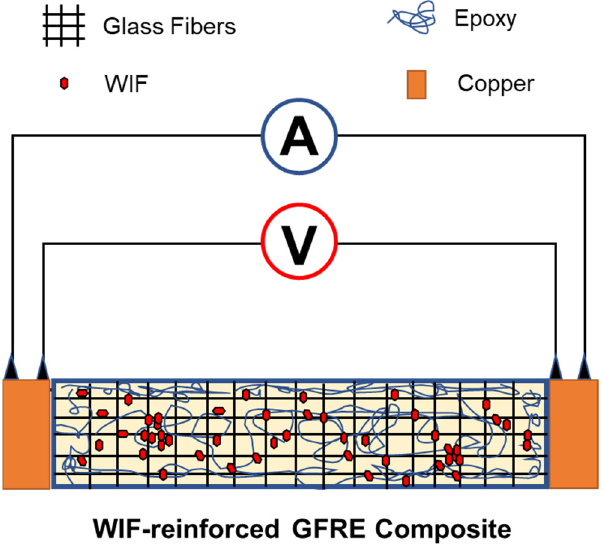
Figure 1. Four-point probe method for measuring the electrical conductivity of the WIF-reinforced GFRE